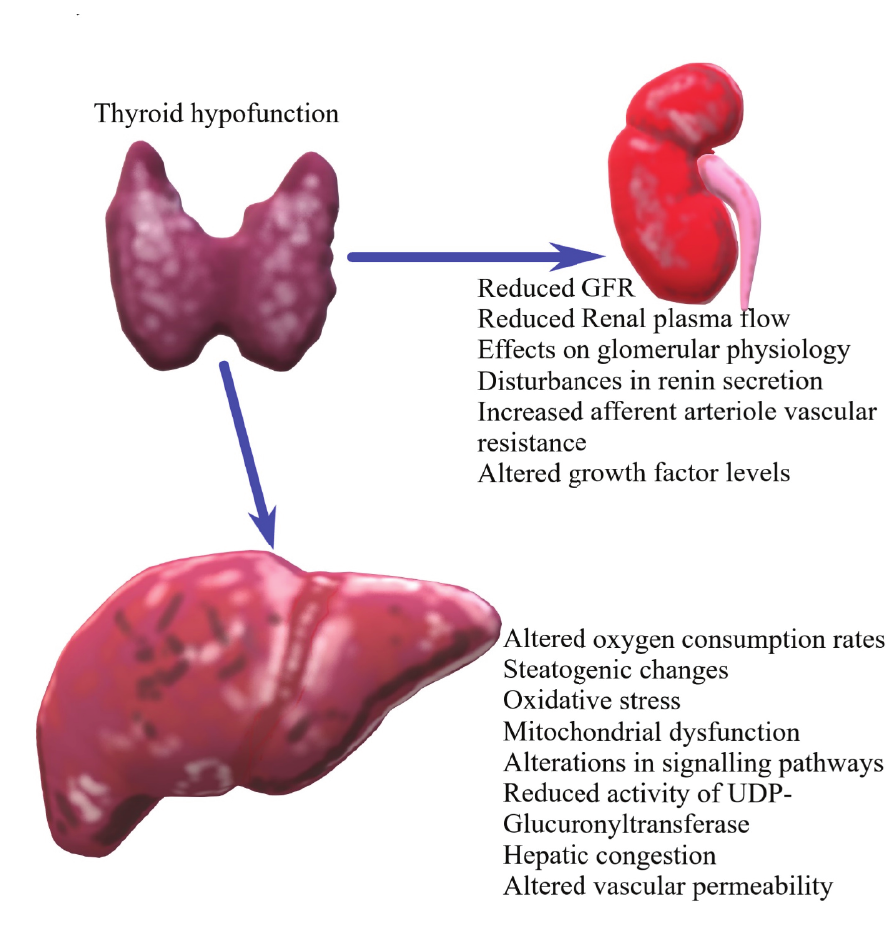
Figure 2 : Underlying mechanisms for the effects of thyroid hypofunction on the liver and